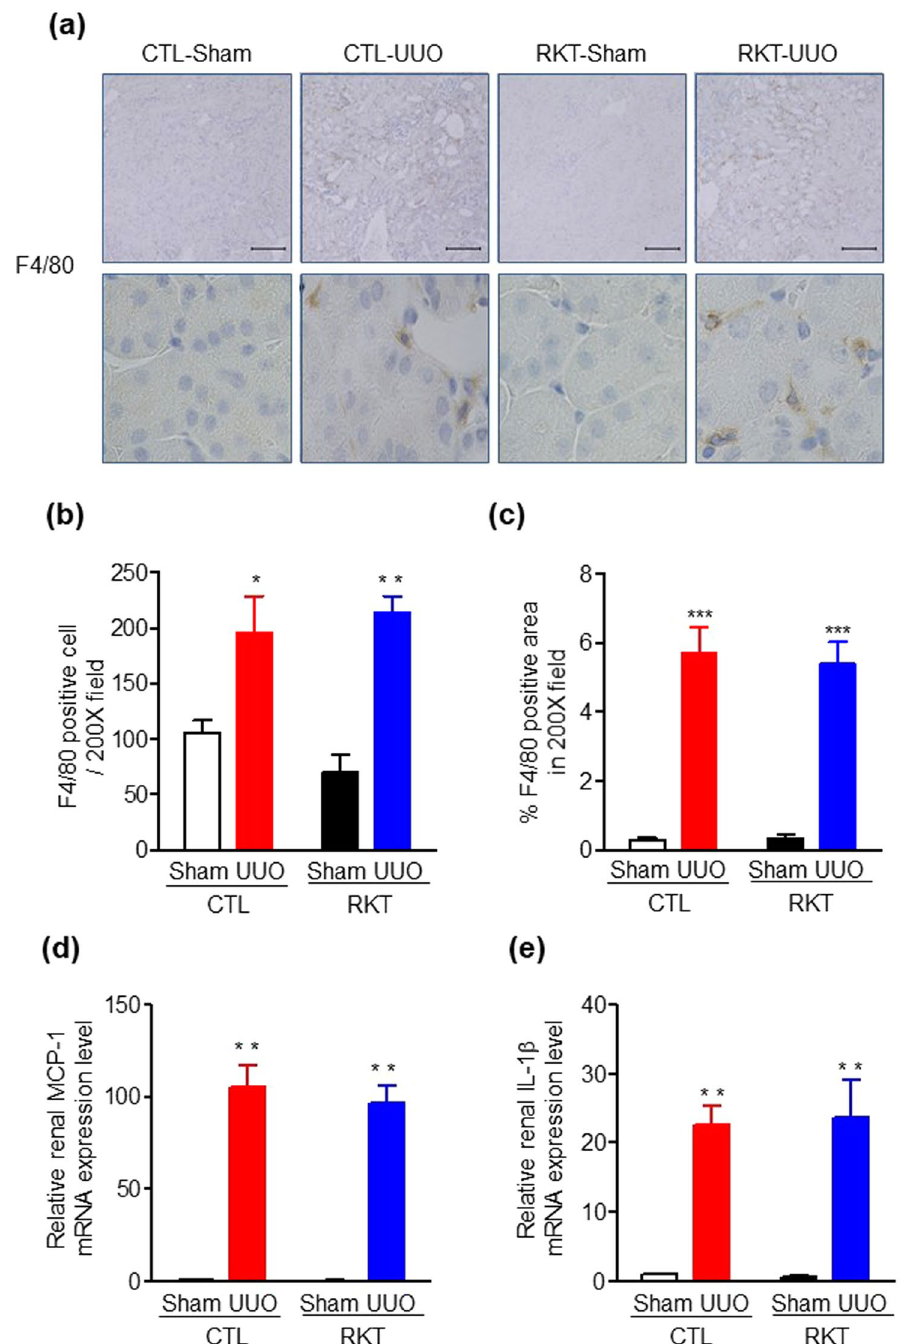
Figure 3. Effects of Rikkunshito treatment on renal inflammation in sham- and UUO-operated mice. ( a ) Representative images of F4/80 immunostaining in kidneys of sham- and UUO-operated mice fed a standard diet and a diet containing Rikkunshito. The positive areas for F4/80 are evident as brown dots in the sections. Original magnification, × 200 (upper panels), and × 400 (lower panels). Scale bar = 100 μ m. ( b ) F4/80-positive cells and ( c ) % F4/80 positive area in kidneys of sham- and UUO-operated mice fed a standard diet and a diet containing Rikkunshito. Quantitative analysis of inflammation-related gene expression in kidney of sham- and UUO-operated mice fed a standard diet and a diet containing Rikkunshito. ( d ) Monocyte chemoattractant protein-1 (MCP-1) and ( e ) interleukin (IL)-1 β . Values are expressed as mean ± SE (n = 6 per group). * P < 0.05, ** P < 0.01 vs sham-operated group. Differences between sham and UUO mice within each diet and between CTL and RKT within each surgery were analysed by two-factor ANOVA with Bonferroni’s post-test. CTL, control standard diet; RKT, diet containing Rikkunshito; UUO, unilateral ureteral